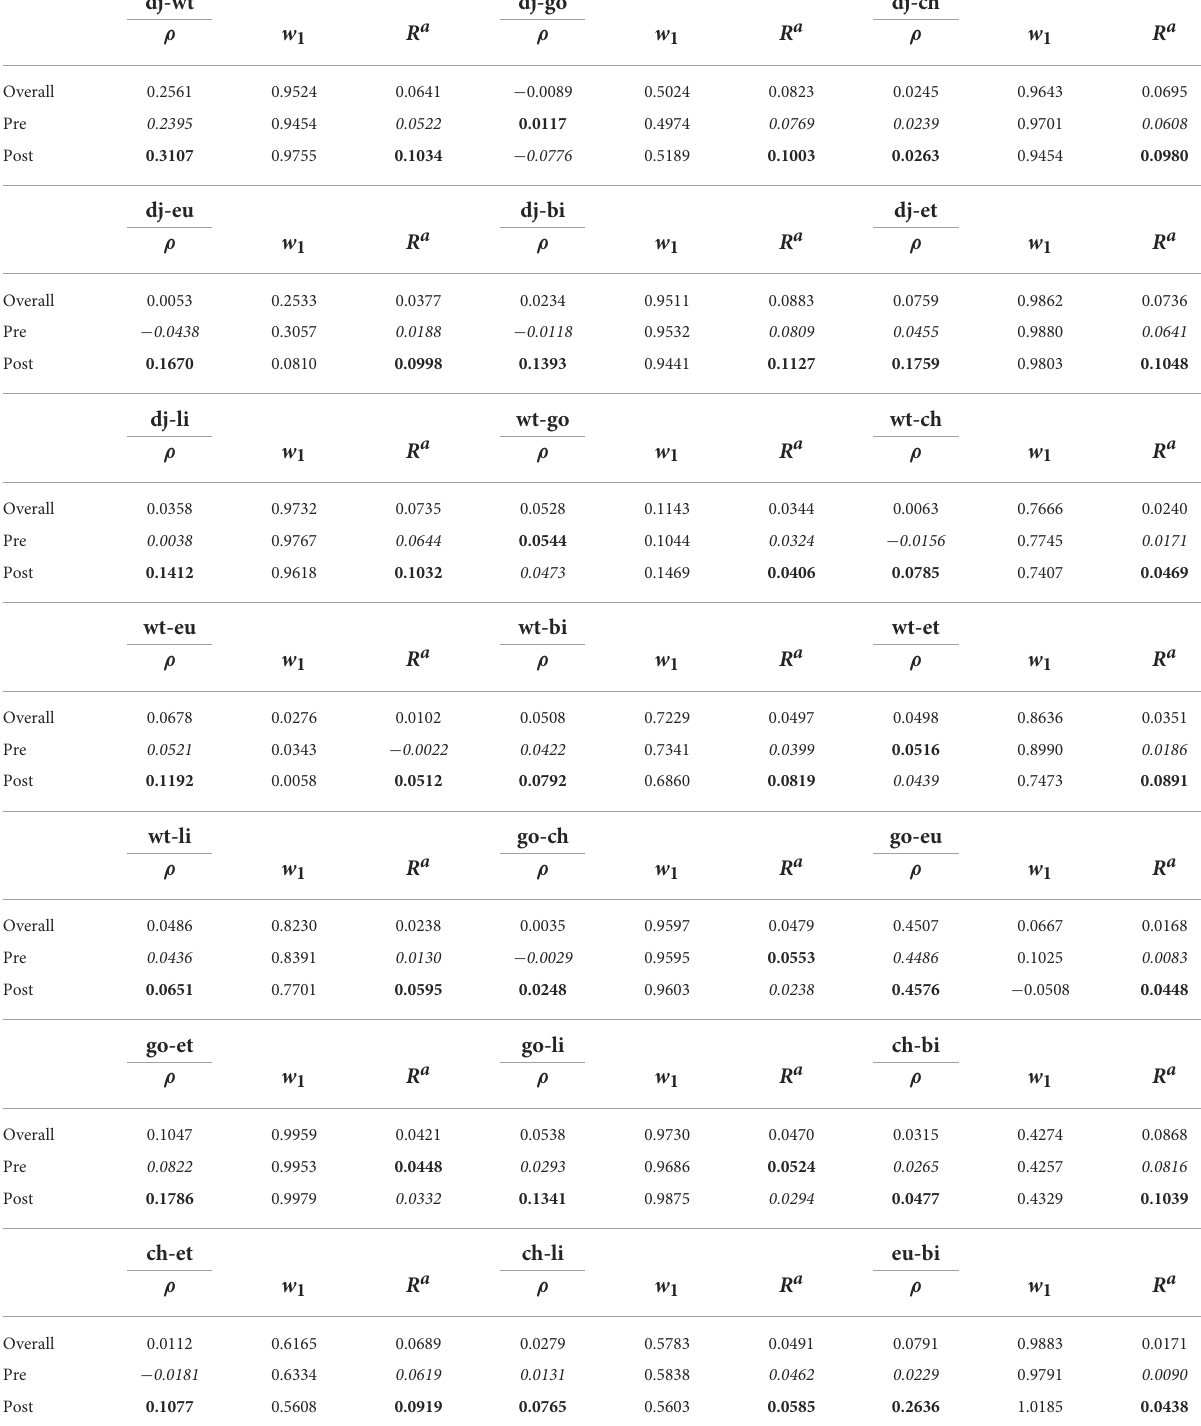
TABLE 5 The optimal asset allocation and the measure of its risk